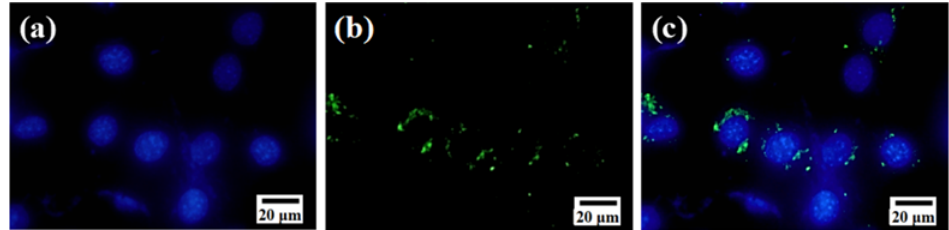
Figure 5. In vitro cellular uptake of DESN (25 µ g · mL − 1 ) in 4T1 cells: ( a ) Blue fluorescence image of cell nuclei stained with DAPI; ( b ) Green fluorescence image of FITC-labeled β -CD/H-MSN in cells and ( c ) Merged fluorescence image of ( a , b ).